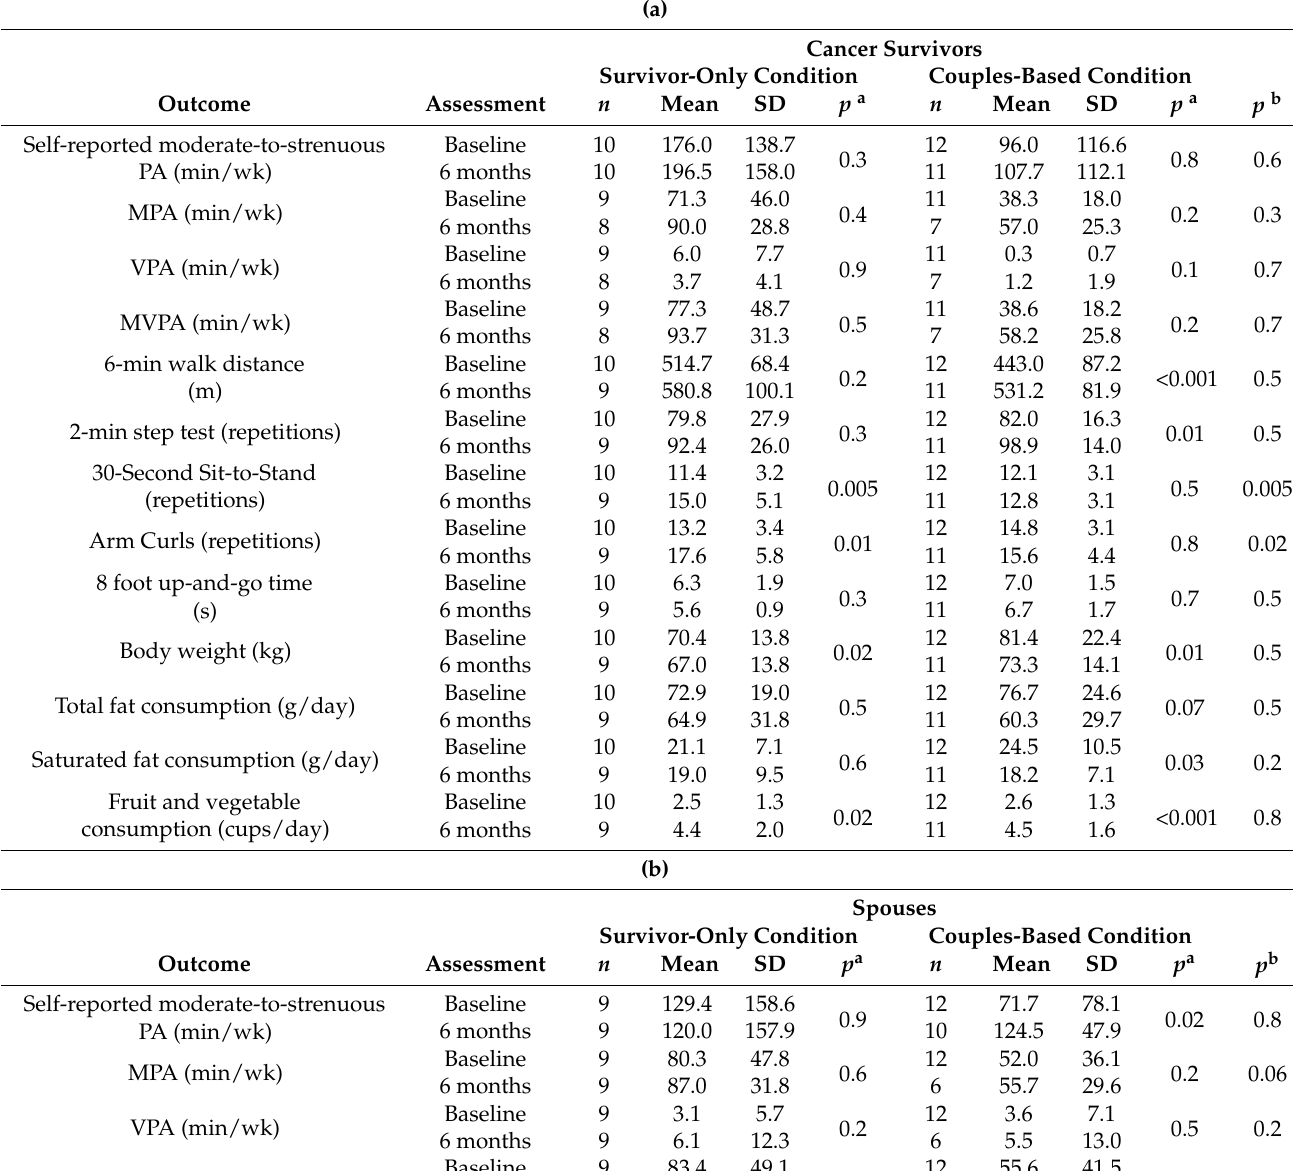
Table 2. ( a ) Summary statistics for outcome measures among cancer survivors by study condition; ( b ) Summary statistics for outcome measures among spouses by study